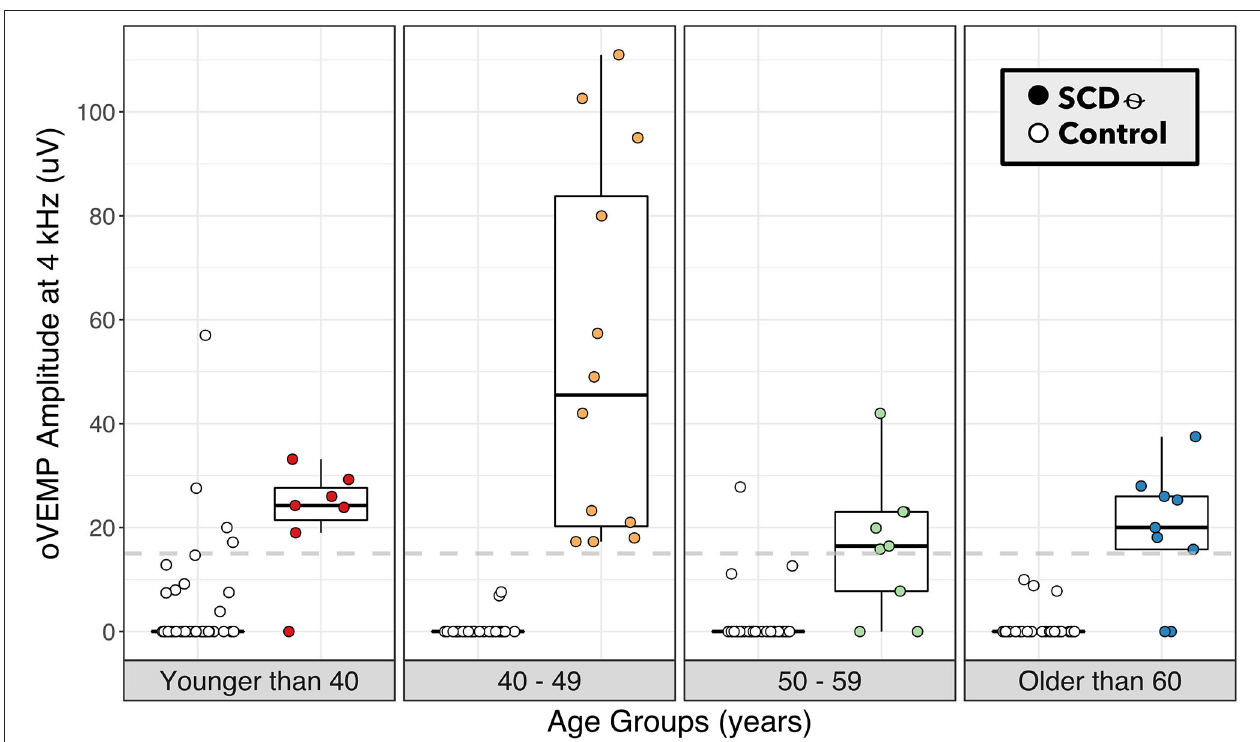
FIGURE 3 | 4kHz oVEMP amplitude binned by age category for SCD θ and control. 4kHz oVEMP amplitudes of patients with SCD θ (closed circles) and without SCD θ (open circles) separated into age categories of < 40, 40–49, 50–59, and ≥ 60 years old. Dashed line represents the proposed 4kHz oVEMP amplitude cut-off of 15 uV for detecting SCD θ .